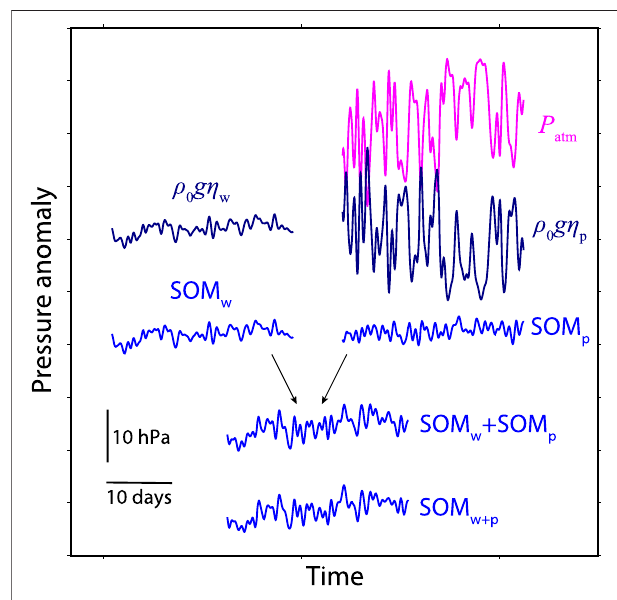
FIGURE2| Imagesofpressurevariationsatseasurfaceandseabottom forced by wind and air pressure in SOM. ρ 0 g η w and ρ 0 g η p are sea level variations respectively forced by wind and atmospheric pressure ( P atm ) in SOM. SOM w , SOM p , and SOM w+p are resultant ocean bottom pressure variations forced by wind, atmospheric pressure, and both